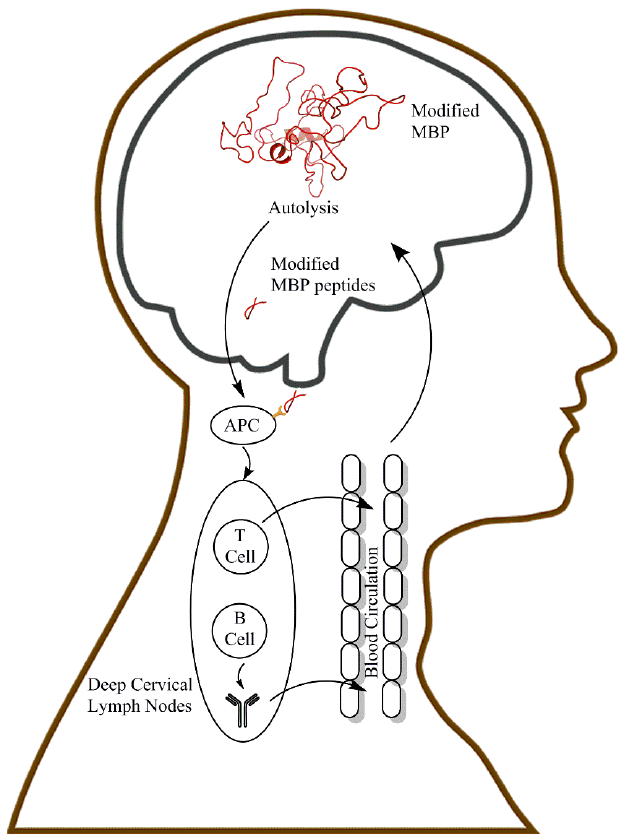
Figure 4. A simplified scheme illustrating how modified MBP in the brain could lead to the induction of MS. One mechanism that could underpin the onset of MS is illustrated. MBP in the human CNS is heavily modified by age 18, with some modification sites being MS-specific. Modified MBP and/or peptides derived from it by autolysis [14,35], or possibly protease action, diffuse via the lymphatic system to the CSF. Subsequent drainage via the lymphatic vessels to the deep cervical lymph node may permit priming of T cell responses. Once primed, T and B cells become self-reactive. In ways analogous to those described for EAE, these self-reactive species cause damage to the myelin and inflammation of the CNS, which manifests as MS (see text for details). APC, Antigen-presenting cell.